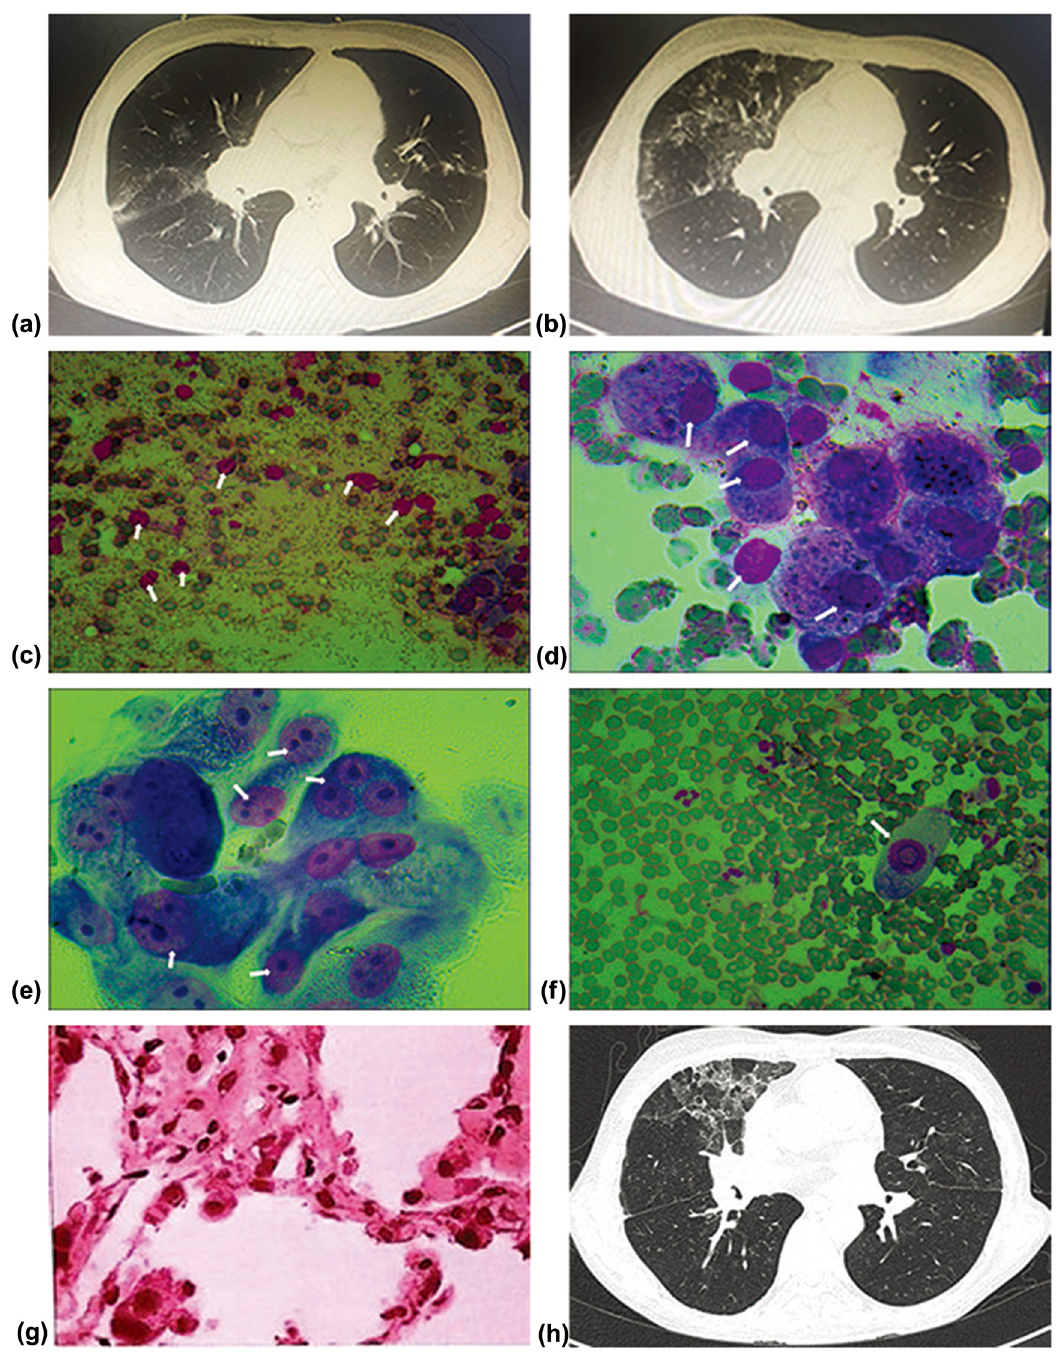
Figure 1: CT, ROSE, and histologic fi ndings of case